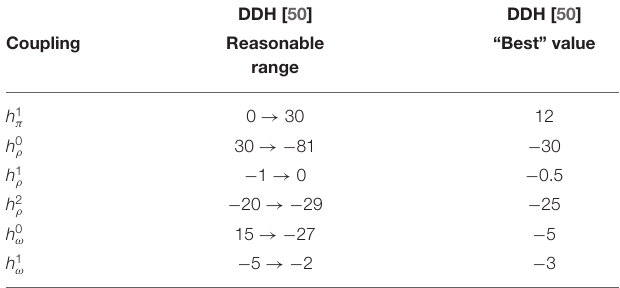
TABLE 3 | Weak NNM couplings as estimated in Desplanques et al. [50]. DDH [50] DDH [50] Coupling Reasonable